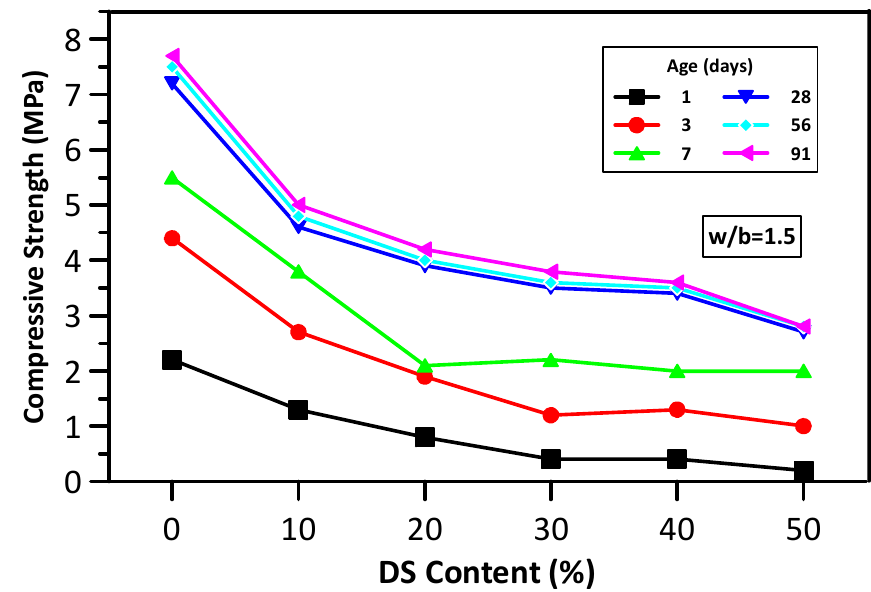
Figure 3. The relationship between the DS content and compressive strength of the CLSM.